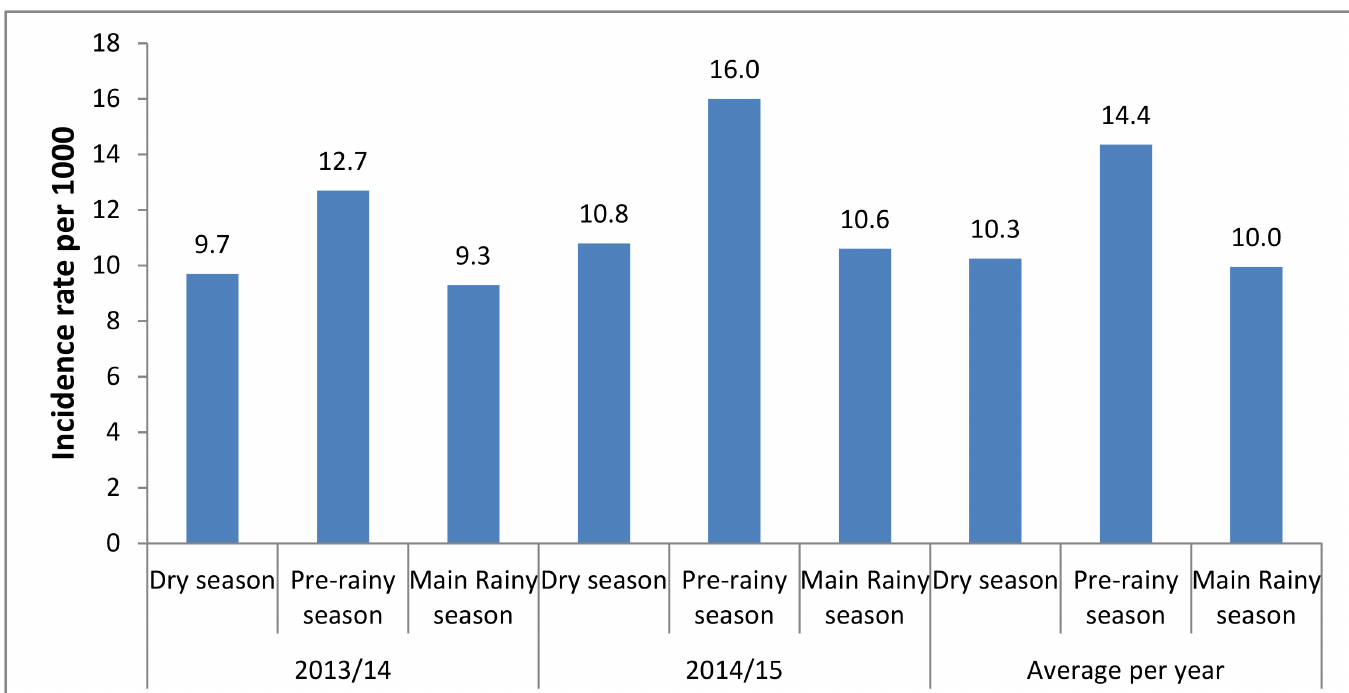
Fig 4. Monthly incidence rate per 1000in dry, pre-rainy and main rain seasons in northwest Ethiopia, from July 2013 to June 2015.